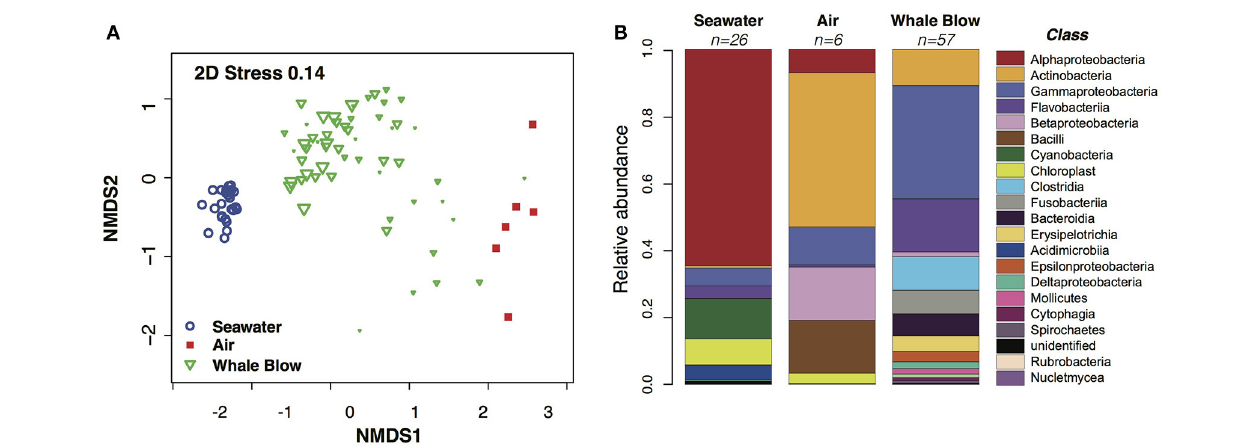
FIGURE 3 | Similarity analysis of Operational Taxonomic Units (OTUs) abundance profiles and comparison of bacterial Classes identified in sampled whale blow, air and seawater. (A) Non-metric multidimensional scaling plot of bacterial OTU abundance profiles. The size of each whale plotting character is scaled to a visual score of the amount of whale blow captured on the petri dish (e.g., bigger the triangle, greater amount of sample). OTUs were defined at 97% nucleotide identity. (B) Relative abundance of taxonomic classes identified as whale-, air- or seawater-specific in each sample